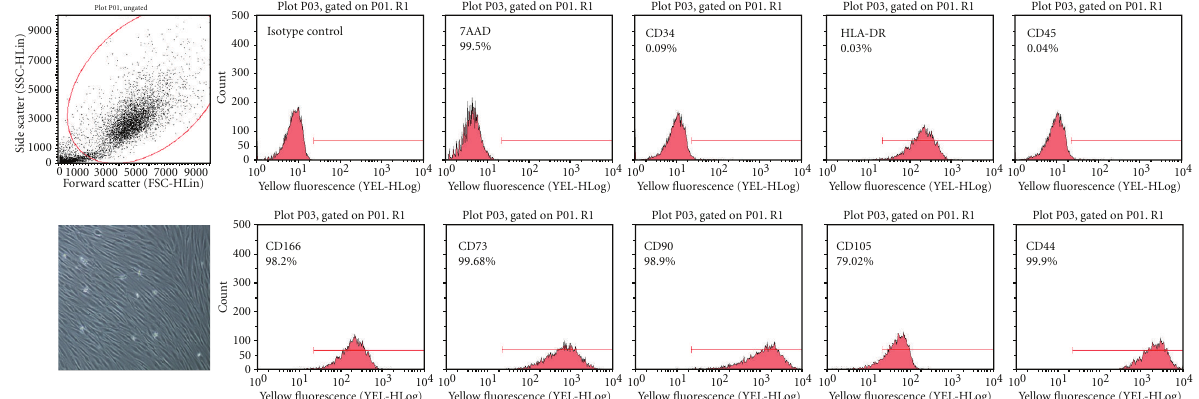
Figure 1: Characterization of adult BM-MSCs prior to transplantation as per ISCT criteria. It shows the plastic adhered spindle-shaped fibroblast like appearance of adult BM-MSCs in culture (lower left panel). And the surface expression of CD markers (top panel: negative markers and lower panel: positive